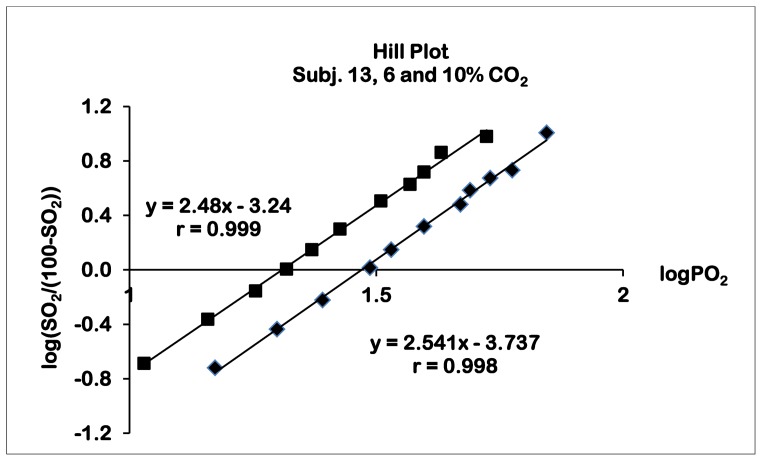
Two oxygen dissociation curves of one subject in the Hill plot.